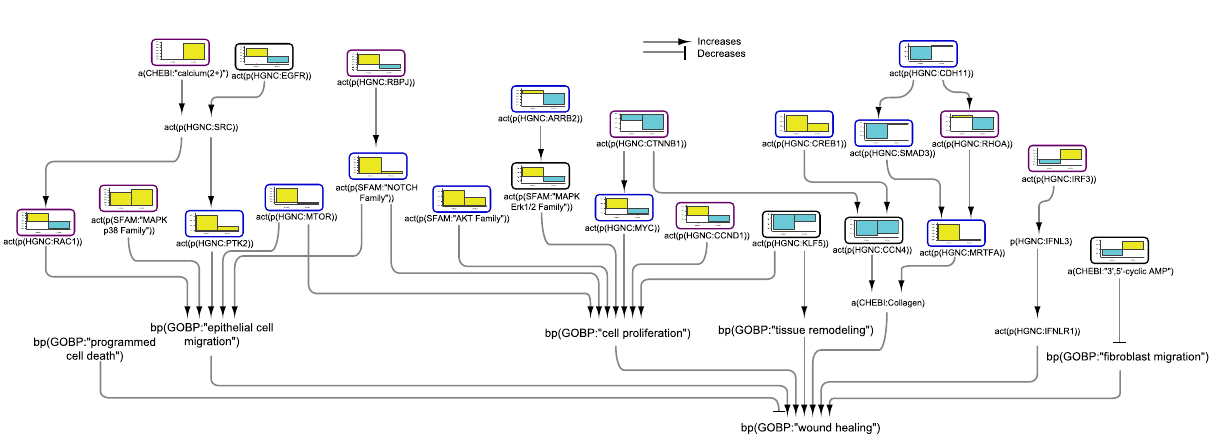
Figure 5. Impact of IBD on signalling leading to wound healing in colonic mucosa. The subgraph extracted from the merged IBD network model shows the iNode enrichment score for each node when the model is scored with comparative transcriptomic data from IBD-affected versus healthy control samples. The values are not comparable between the graphs, and the scale is adjusted on the basis of the highest value for each node. Most intermediate nodes that were not scored have been removed for simplicity (The complete results are in Supplementary file 1). The iNodes leading to “programmed cell death” are shown in Figs. 3 and 6. Black outlines indicate nodes that were significantly impacted in both CD and UC samples; blue outlines indicate nodes that were significantly impacted in CD samples; and purple outlines indicate nodes that were significantly impacted only in UC samples. The directionalities are shown as yellow or turquoise bars for inferred upregulation or downregulation, respectively. The order is as follows: 1) CD and 2) UC. Abbreviations: act, protein activity; p, protein abundance; bp, biological process. HGNC is the namespace for human proteins; GOBP is the namespace for biological processes; MESHD is the namespace for diseases; and GOCC is the namespace for complexes. SFAM and PMIBP are custom namespaces for protein families and biological processes, respectively. The figure was created using Cytoscape v3.7.1 (https:// cytos cape. org). The Cytoscape graph was then exported to pdf and the layout was further modified for better readability in Adobe Illustrator 2019 (https:// adobe.